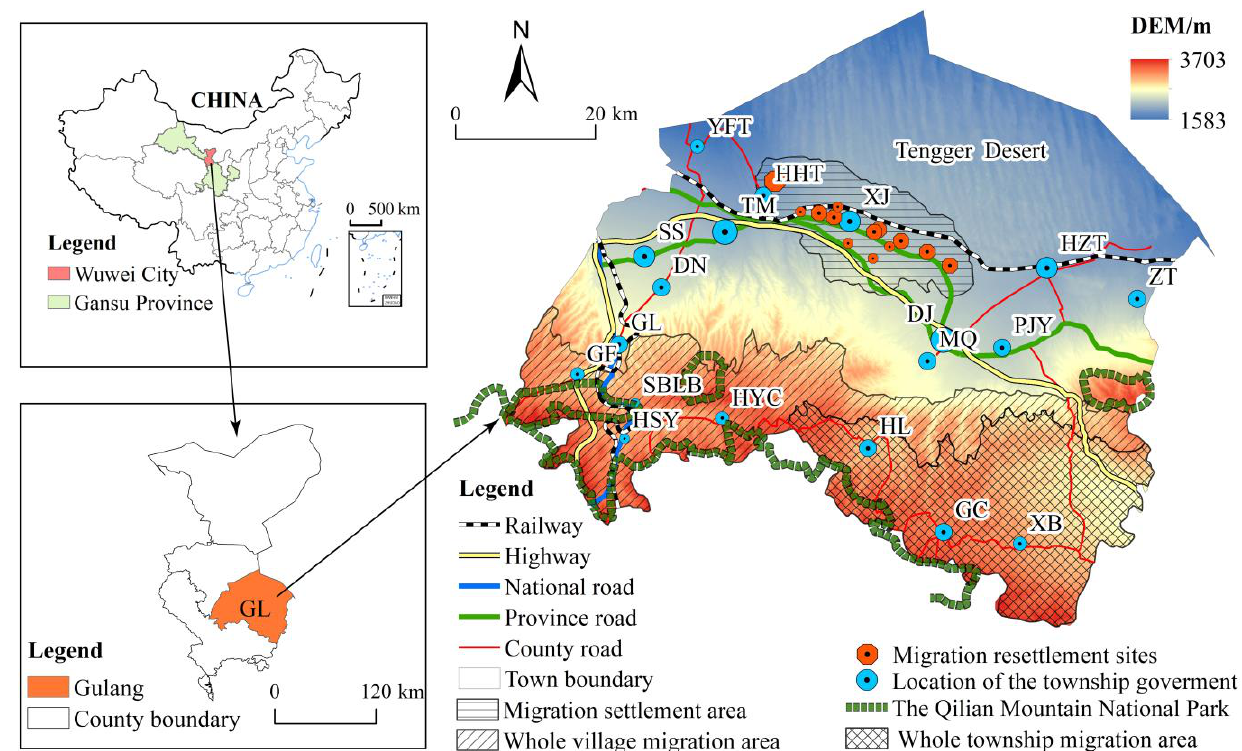
Figure 2. Location and elevation of the study area. The abbreviations of the townships’ names in the map are as follows: HSY, Heisongyi; SBLB, Shibalipu; GF, Gufeng; DN, Dingning; SS, Sishui; TM, Tumen; YFT, Yongfengtan; HHT, Huanghuatan; XJ, Xijing; DJ, Dajing; MQ, Mingquan; HL, Hengliang; GC, Gancheng; XB, Xinbu; PJY, Peijiaying; ZT, Zhitan; HZT, Haizitan.